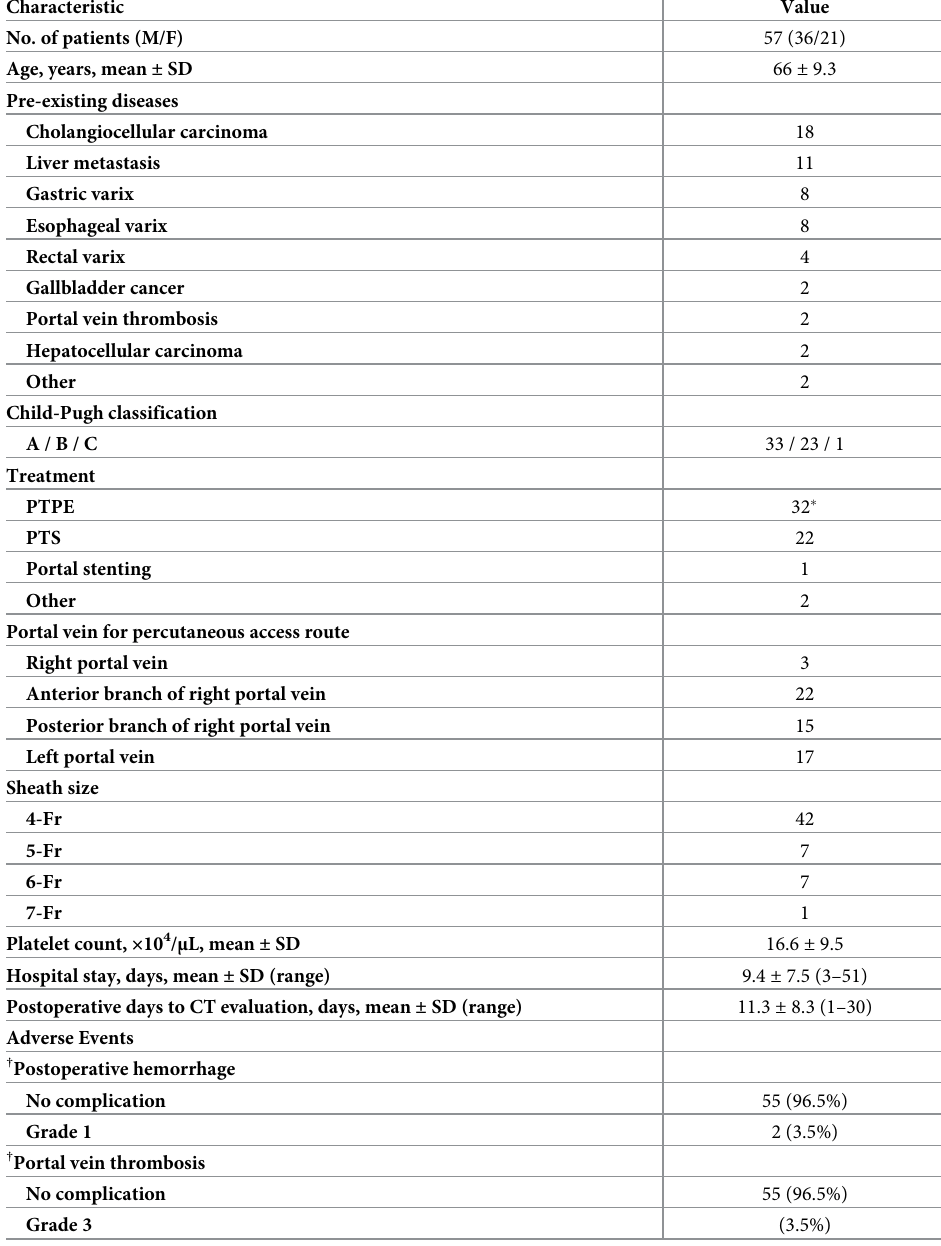
PTPE, percutaneous transportal embolization; PTS, percutaneous transhepatic sclerotherapy; SD, standard deviation. � Ipsilateral puncture in 29 cases; contralateral puncture in 4 cases. † As graded by Common Terminology Criteria for Adverse Events (CTCAE) version